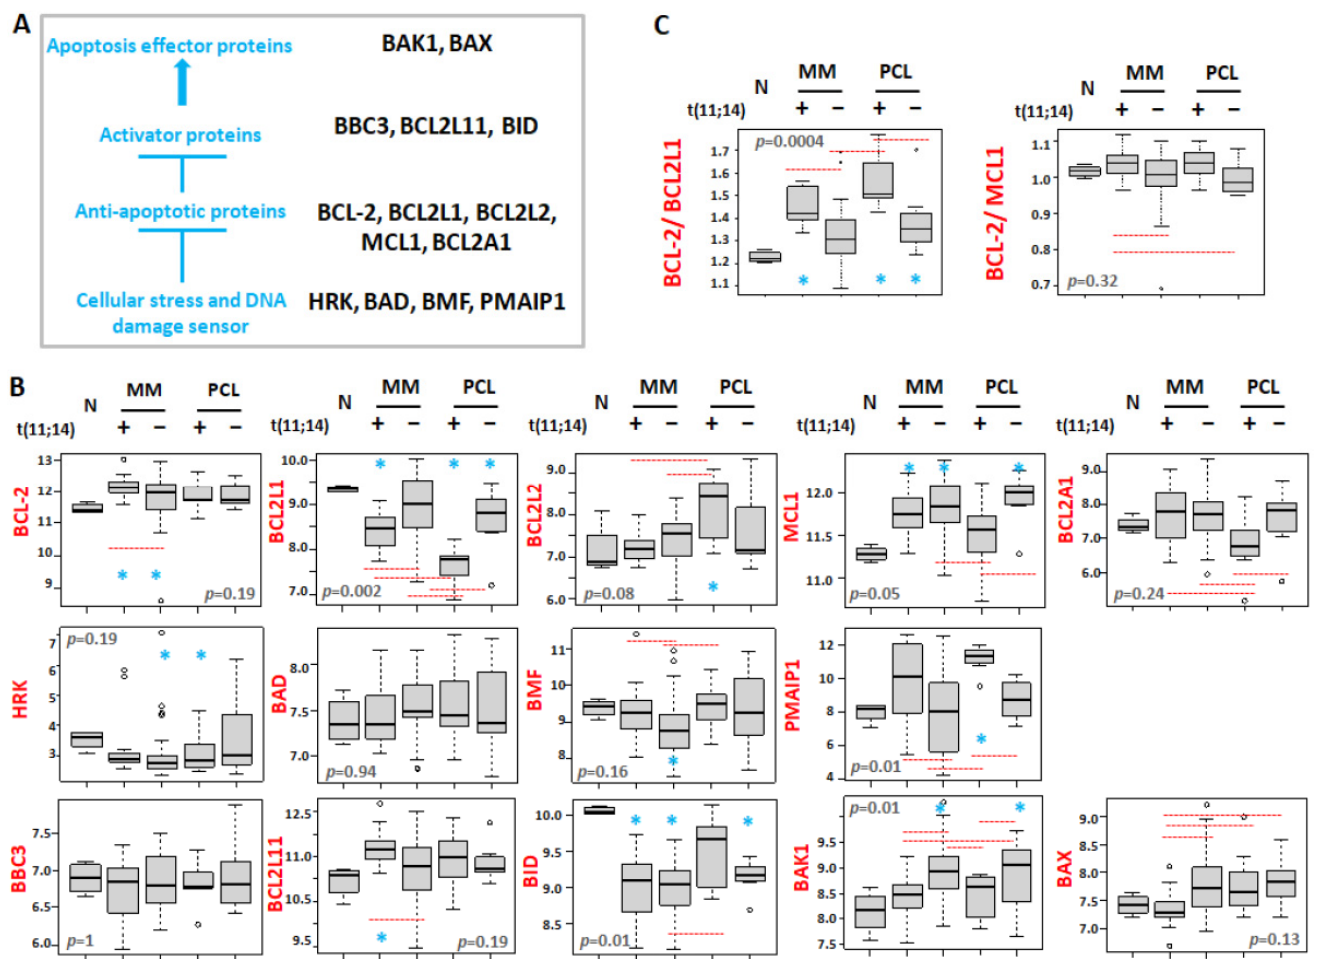
Figure 3. ( A ) Scheme of the BCL2 family protein interactions. ( B ) Box plot representation of the mRNA expression of BCL2 family genes in 4 normal controls (N), 12 MM patients carrying t(11;14), 38 MMs without t(11;14), 7 pPCL patients carrying t(11;14), and 8 pPCLs without t(11;14) evaluated by GeneChip ® Human Gene 2.0 ST array (GSE116294). ( C ) Box plot representation of the ratio BCL2/BCL2L1 and BCL2/MCL1 expression in each group. In each panel, red dashed lines below/above two groups indicate significant differences in their gene expression level; blue asterisks indicate significant differences between the indicated group and N (Dunn’s test p -values are reported in Figure S2). BH adjusted Kruskal–Wallis test p -value is reported for each panel.